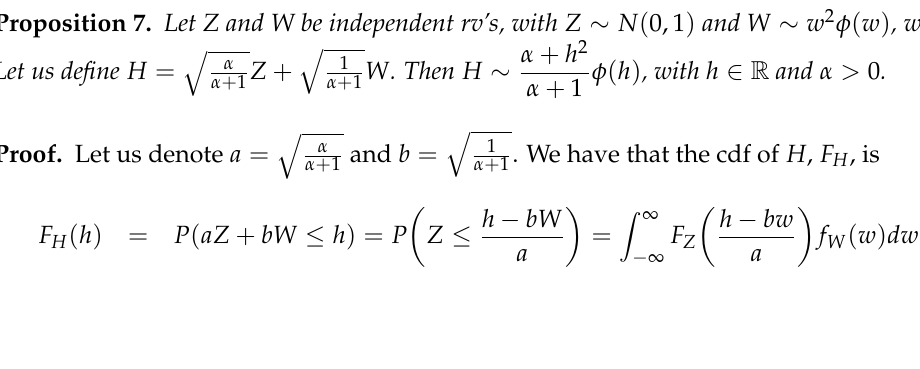
(cid:112) Figure 4. ( a ) β 1 as function of λ ( α = δ = 1 ) ; ( b ) β 2 as function of λ ( α = δ = 1 ) ; ( c ) function of α and λ ( δ = 1 ) ; ( d ) β 2 as function of α and λ ( δ = 1 )